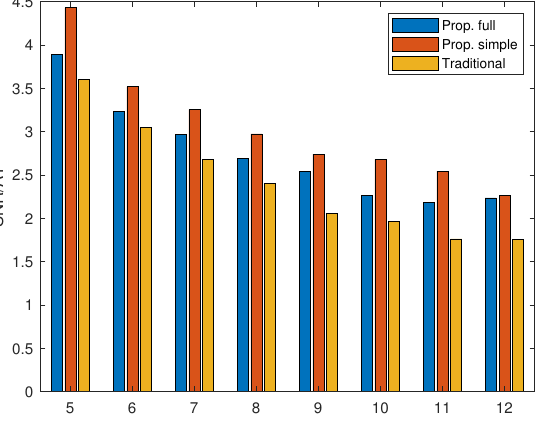
Prop. full Prop. simple Traditional